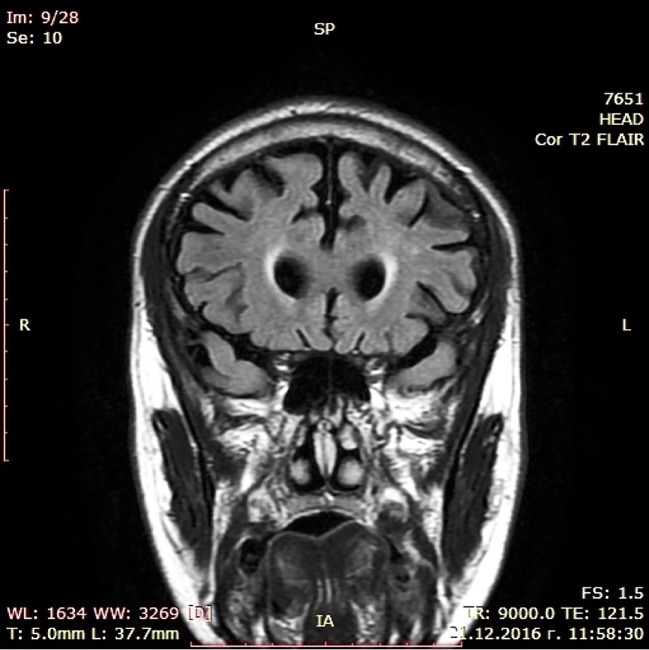
MRI scan (coronal).